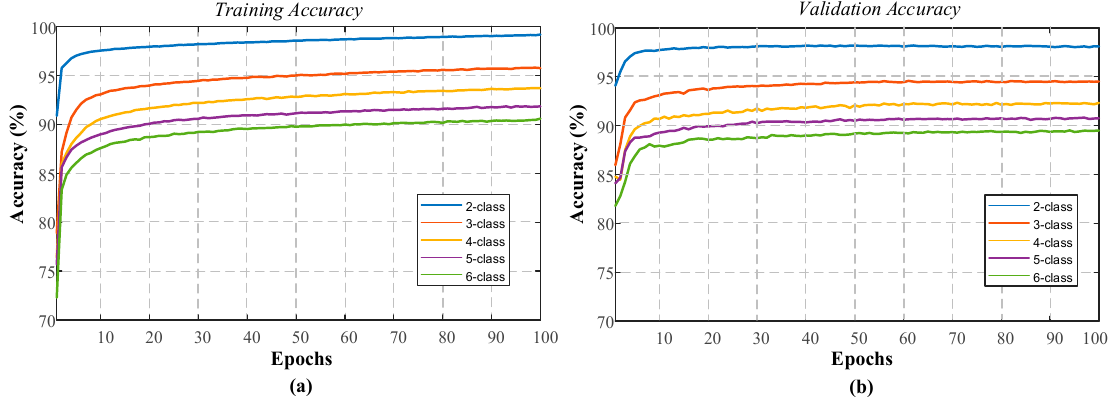
Figure 11. Performance graphs obtained for the proposed model using sleep-edfx database with single-channel EEG: ( a ) training accuracy, and ( b ) validation accuracy.